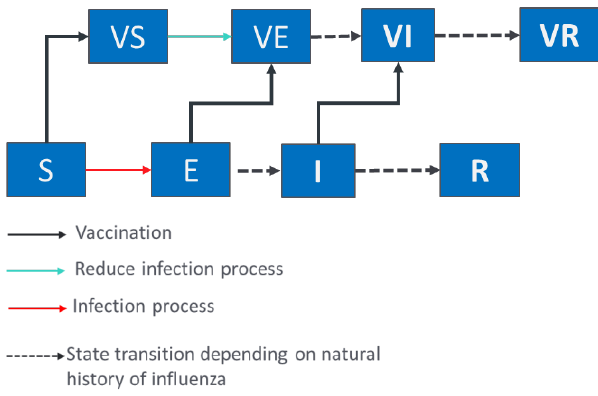
Figure 1. Diagram of the influenza transmission model. S i , E i , I i , and R i stand for susceptible, exposed, infectious, and recovered individuals respectively regarding the influenza strain I ; VS i , VE i , and VI i stand for susceptible, exposed and infectious individuals experiencing a non-protective vaccination respectively regarding influenza strain i , VR i are individuals protected and vaccinated against influenza strain; i stands for influenza strains: A/H1N1, A/H3N2, B Victoria, B Yamagata.